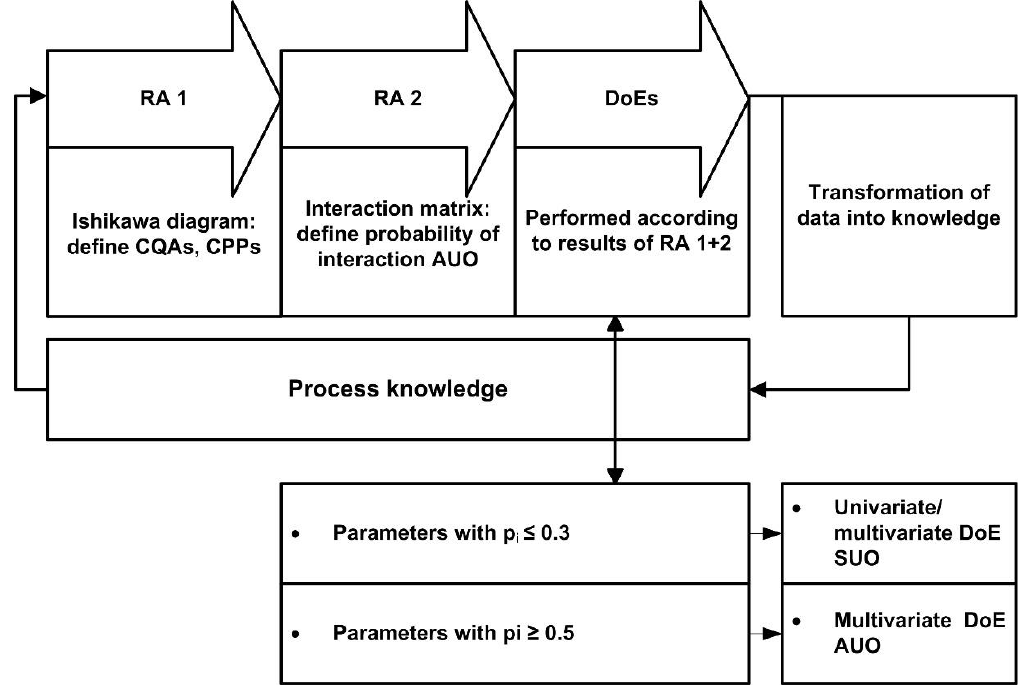
Figure 2. Novel Quality by Design (QbD) workflow comprising the interaction matrix in risk assessment 2 (RA 2) as key step for the integrated design of experiments (DoE) design across unit operations. Risk analysis starts with a double-stage assessment of criticality. RA 1 defines Critical Quality Attributes (CQAs), Critical Process Parameters (CPPs) and gives a first evaluation of possible Across Unit Operations (AUO)-interactions. RA 2 rates the potential interacting parameters by assigning a probability of interaction (pi)